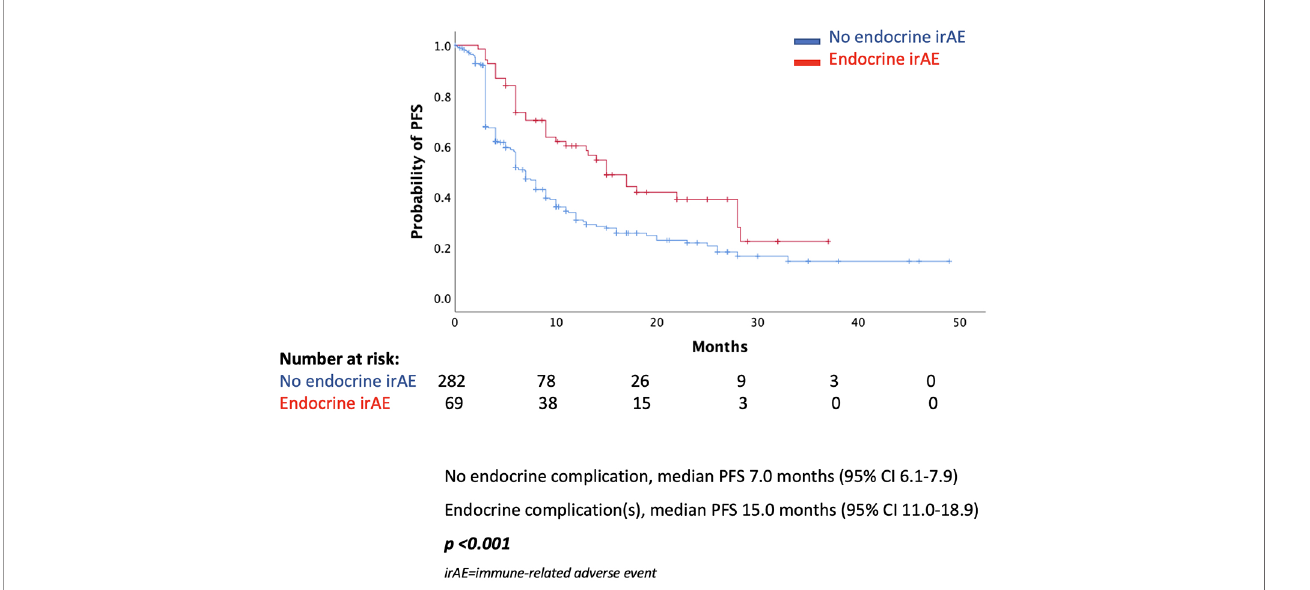
FIGURE 1 | Progression-free survival according to the presence of endocrine